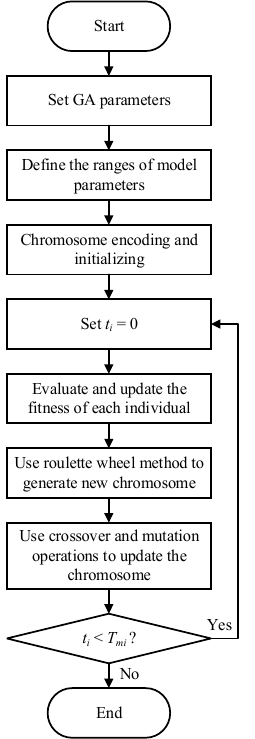
Figure 14. Flowchart of the genetic algorithm (GA) to identify model parameters.